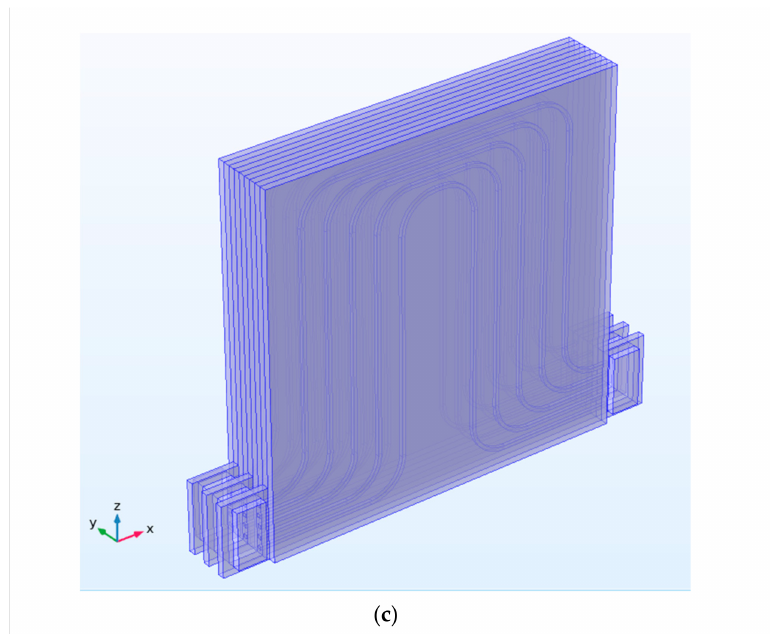
Figure 6. Liquid cooling setup: ( a ) Schematic of the liquid cooling arrangement for Li-ion battery stack; ( b ) The geometry of the battery model with inlet and outlet connector channel; ( c ) coolant flow channels inside battery